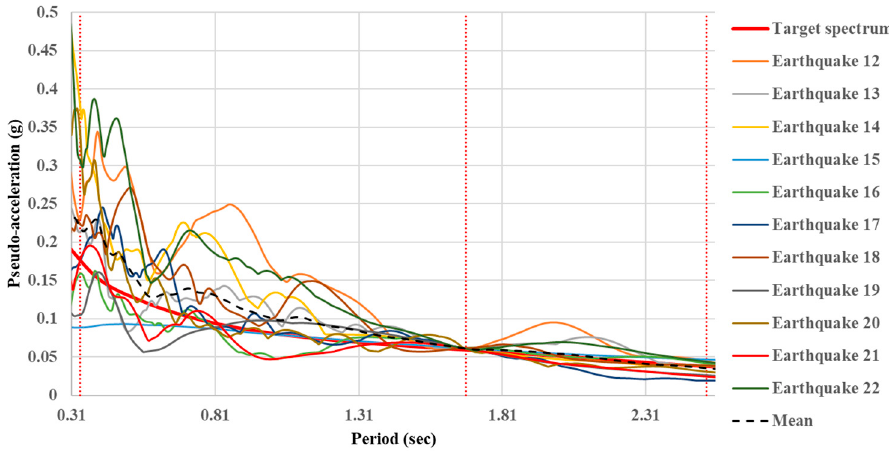
Figure 6. Ground motion selection for Agua Prieta, Sonora, corresponding to a return period of 475 years with respect to the reinforced concrete building.